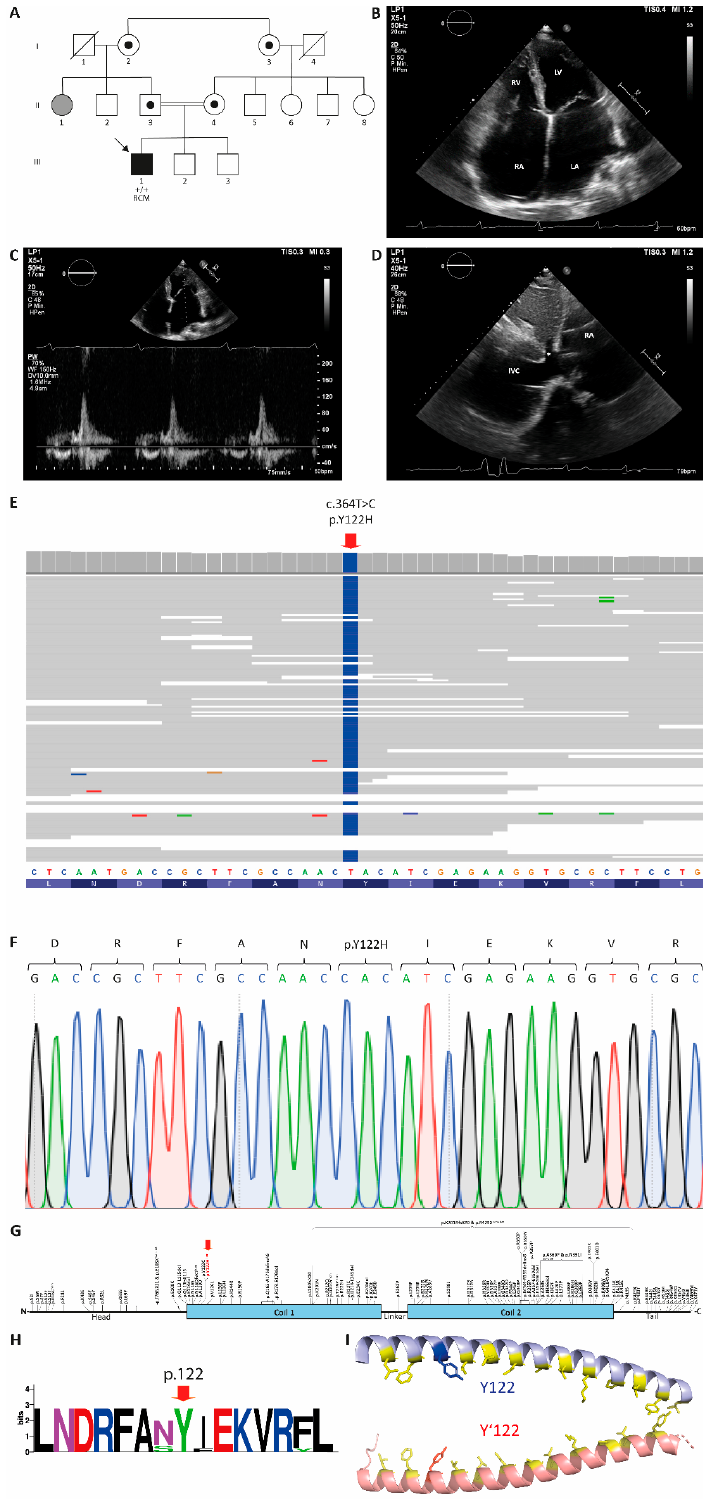
Figure 1. ( A ) Pedigree of the family. Circles represent females, squares represent males, and a slash denotes deceased. Black-filled symbols indicate a cardiac phenotype. Grey-filled symbols indicate individuals with skeletal myopathy. RCM, restrictive cardiomyopathy and +/+ indicates